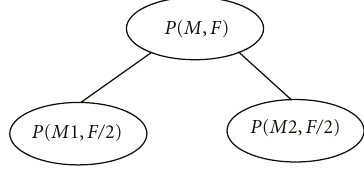
Figure 5: Recursive problem P(M,F) of scheduling of matrix M into a scheduling frame with F time slots.